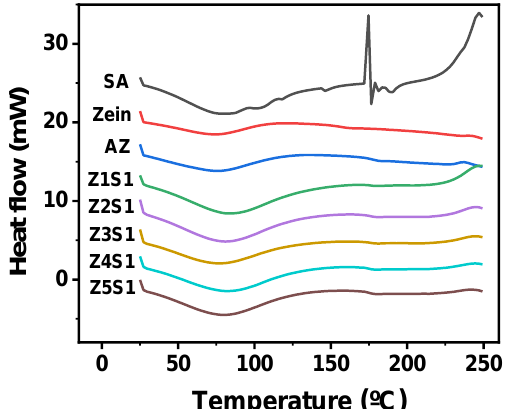
Figure 6. Differential scanning calorimetry (DSC) curves of SA, zein, AZ, and ZS particles with different ratios.